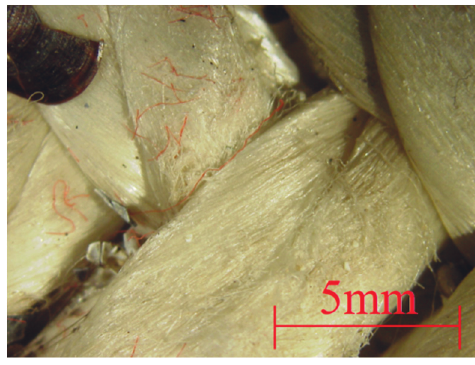
Figure 18. Red strands from anti-friction membrane evident in areas exhibiting wear of rope yarns.